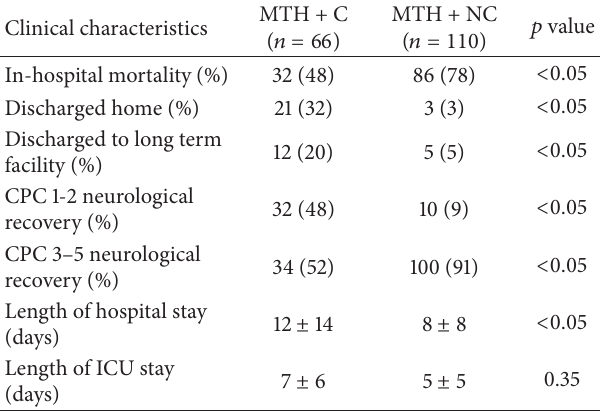
Table 2: Cardiac catheterization findings in study population who underwent MTH + C ( 𝑛 = 66 ).